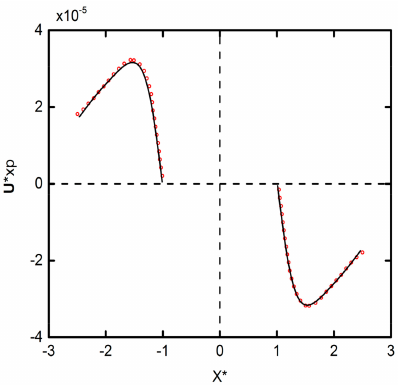
Figure 2. The velocity comparison of the two results. The lines and symbols represent results of this paper and Qian’s results [23], respectively.